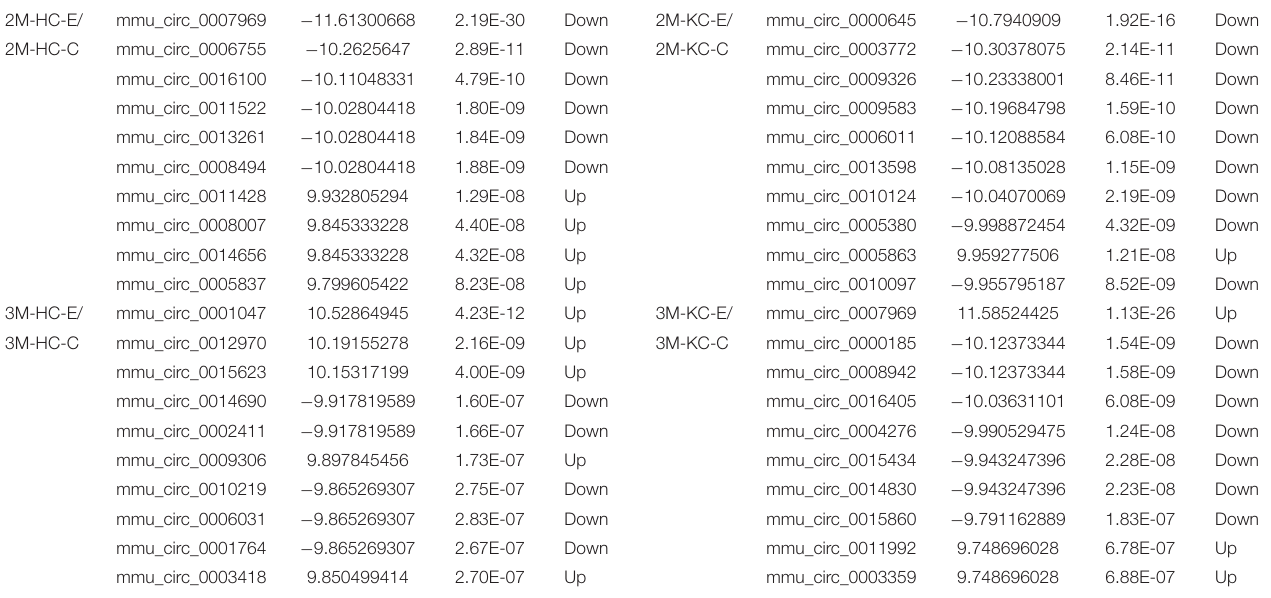
TABLE 2 | Top 10 dysregulated circRNAs in hepatocytes of murine liver after E. multilocularis infection. Group